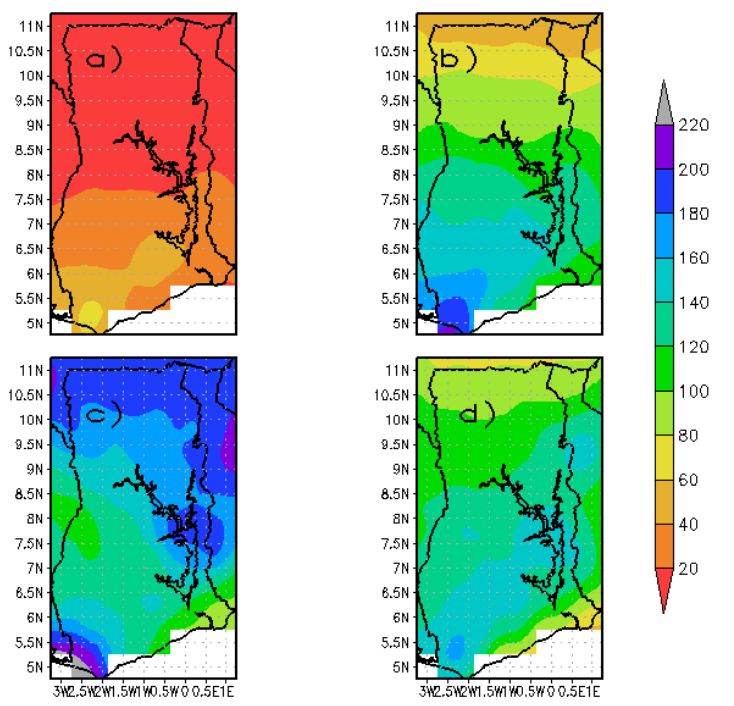
Figure 9. Seasonal mean rainfall (mm) over Ghana for ( a ) DJF; ( b ) MAM; ( c ) JJA; ( d ) SON during the 1901–2010